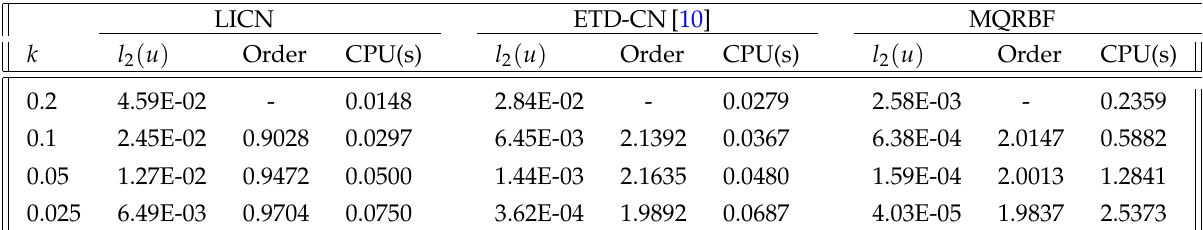
Table 1. Comparison of the schemes LICN, ETD-CN and MQRBF for Test Problem 1 in terms of l 2 norm error, rates of convergence, and computational efficiency at t = 10.0 (only dimensionless concentration u